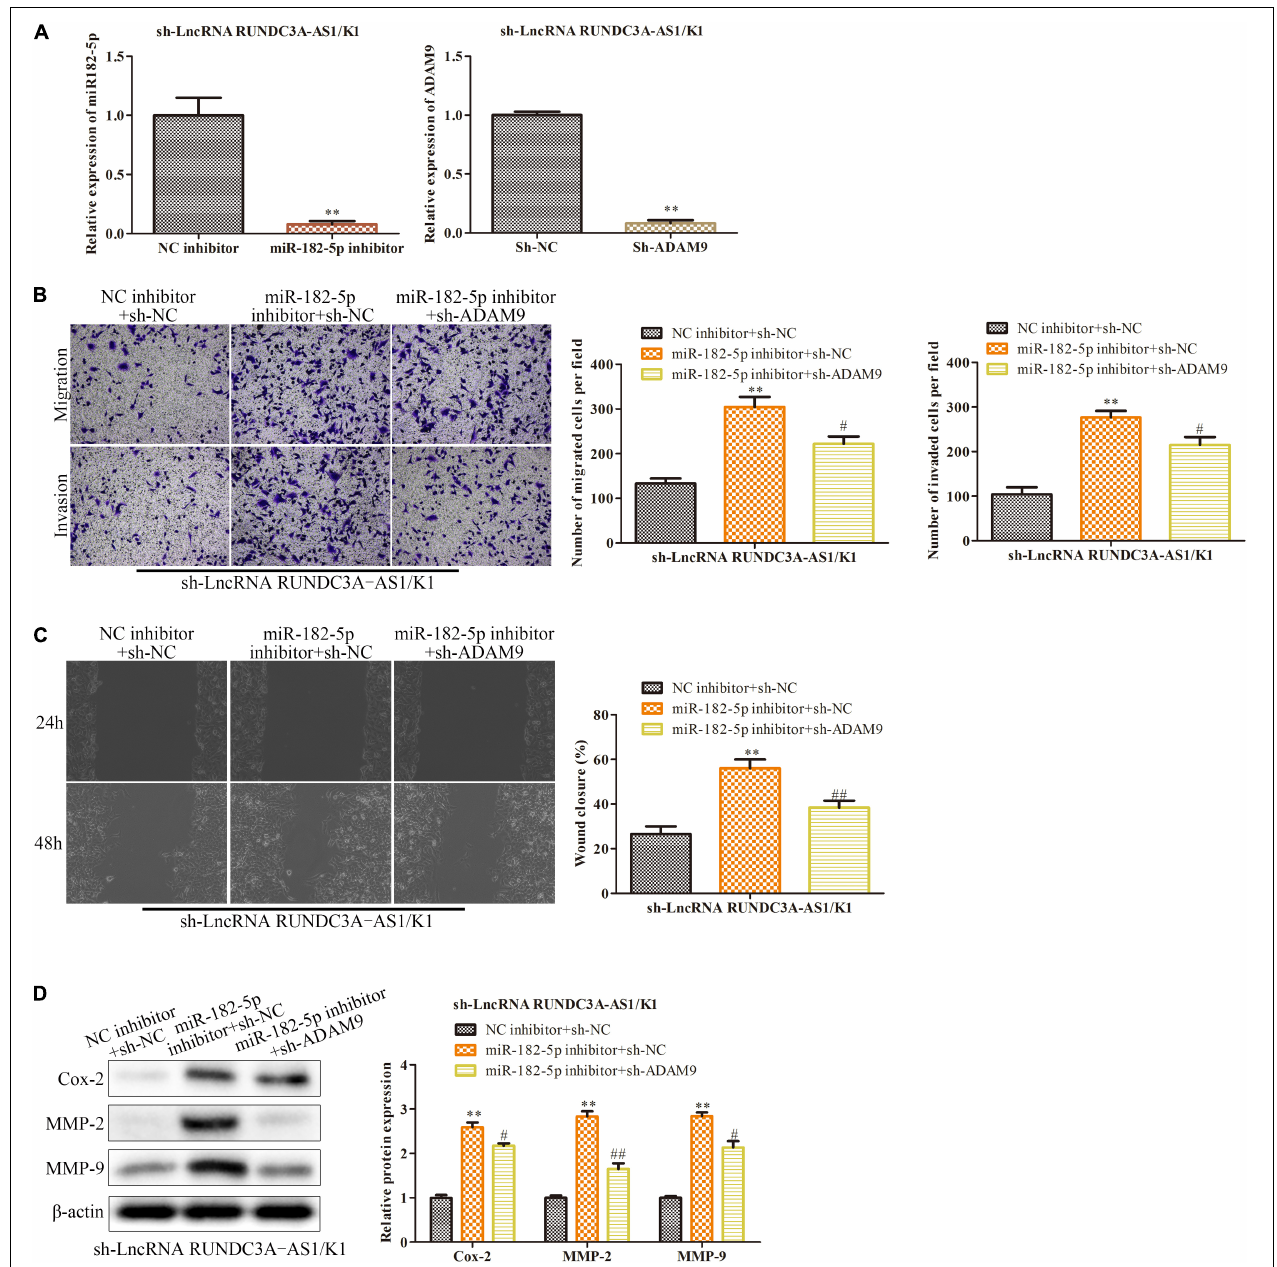
FIGURE 6 | LncRNA RUNDC3A-AS1 promotes thyroid cancer cell migration and invasion by regulating miR-182-5p/ADAM9 axis. Either miR-182-5p inhibitor or ADAM9 shRNAs were transfected into the RUNDC3A-AS1 knockdown K1 cells. (A) RT-qPCR was performed to evaluate the efficiency of miR-182-5p inhibitor and ADAM9 knockdown. ** P < 0.01 vs. the NC inhibitor group and the sh-NC group, respectively. (B) Transwell chamber assay for cell migration and invasion. (C) Cell capacity of migration (scratch test). (D) Western blot analysis of the expression level of migration related proteins (Cox-2, MMP-2, and MMP-9). ** P < 0.01 vs. the sh-NC + NC inhibitor group. # P < 0.05, ## P < 0.01 vs. the miR-182-5p inhibitor + sh-NC group. The data were presented as mean ± SD and the experiments were repeated 3 times.